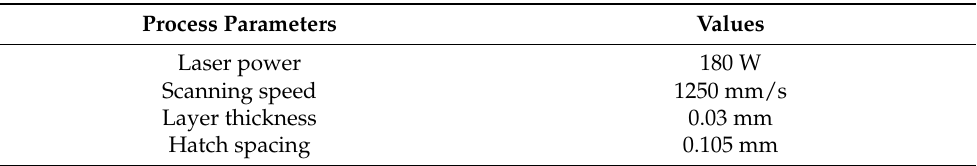
Table 4. Process parameters used for this study. Reprinted with permission from ref. [47]. Copyright 2022